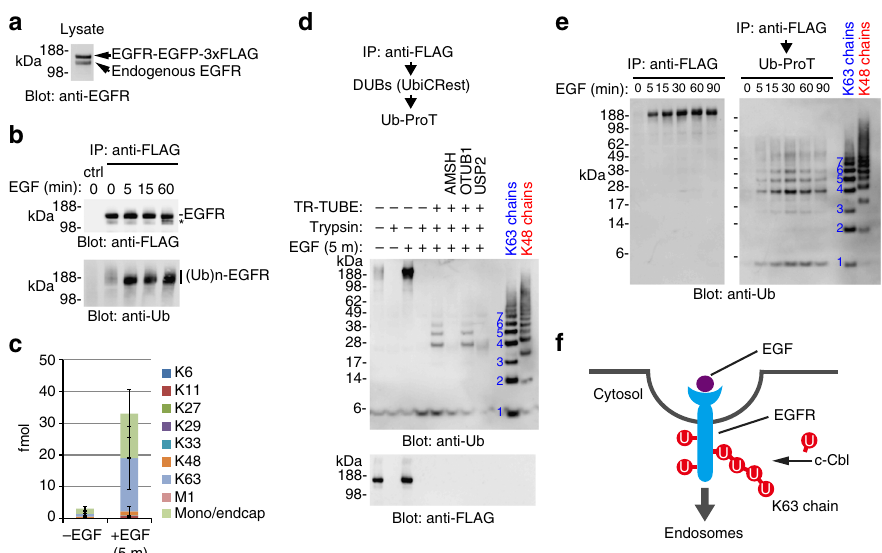
Fig. 6 Ubiquitin chain length and composition of ligand-activated EGFR. a Anti-EGFR blot of HeLa cells stably expressing EGFR-EGFP-3×FLAG. b Ubiquitylation of EGFR. After 100 ng ml − 1 EGF treatment, EGFR-EGFP-3×FLAG was immunoprecipitated with anti-FLAG antibody and subjected to immunoblotting with indicated antibodies. Parental wild-type HeLa cells were also analyzed (ctrl). Degraded EGFR is indicated by an asterisk. c Absolute quanti fi cation of ubiquitin linkages in immunoprecipitated EGFR-EGFP-3×FLAG. The gel region above 120 kDa was subjected to Ub-AQUA/MS analysis (mean ± s.d.; n = 2 biological replicates; Supplementary Data 7). d Ub-ProT analysis of ubiquitylated EGFR combined with UbiCRest assay. Immunoprecipitated EGFR was treated with K63 linkage-speci fi c AMSH, K48 linkage-speci fi c OTUB1, or nonspeci fi c USP2, followed by Ub-ProT. e Time- dependent changes of ubiquitin chains on EGFR. After EGF treatment, EGFR-EGFP-3×FLAG was immunoprecipitated at the indicated times and analyzed by Ub-ProT. f A possible model for ubiquitin chain architecture of ubiquitylated